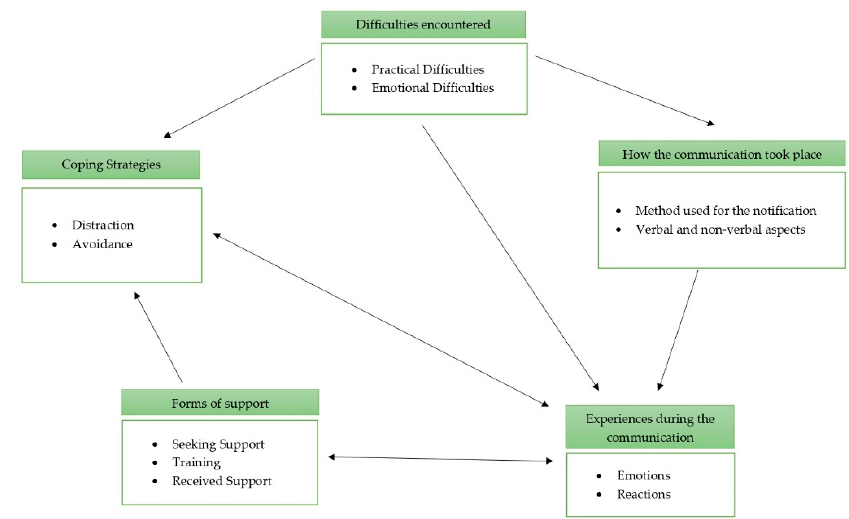
Figure 1. Links among themes.